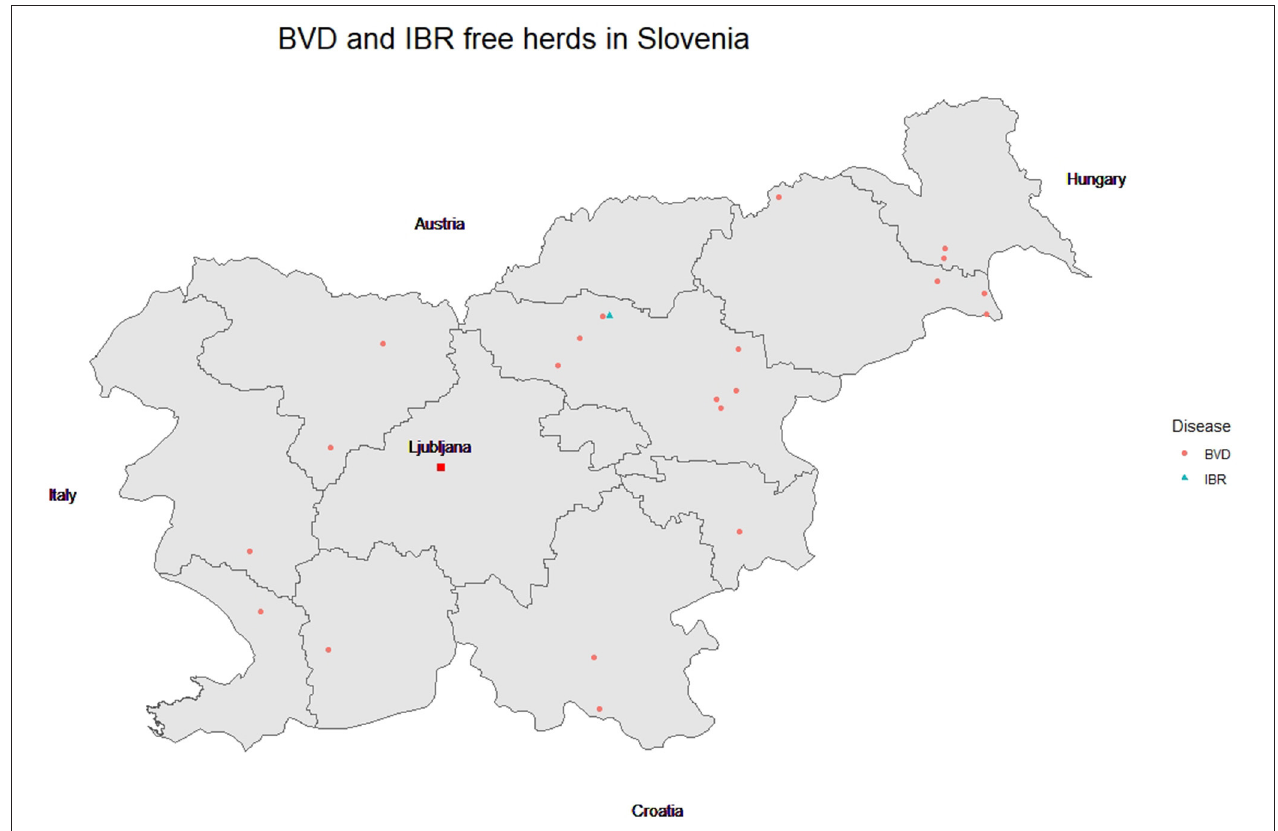
FIGURE 3 | Location of bovine viral diarrhoea (BVD) or infectious bovine rhinotracheitis (IBR) officially free herds. Note that the only herd free of IBR also has a BVD-free status but the markers are misaligned for better visualisation.